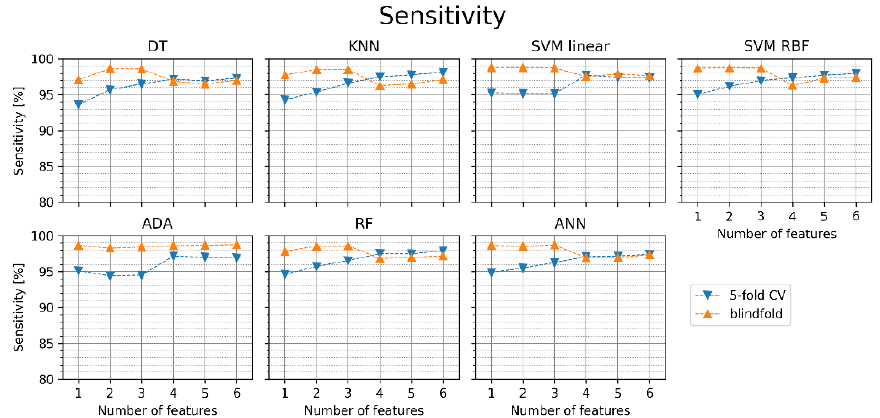
Figure 6. Sensitivity of atrial fibrillation detection for different classifiers with sets of one to six fea- tures (orange points — blindfold validation, blue points — 5-fold cross-validation). DT — decision tree, KNN — K nearest neighbors, SVM linear — support vector machine with linear kernel, SVM